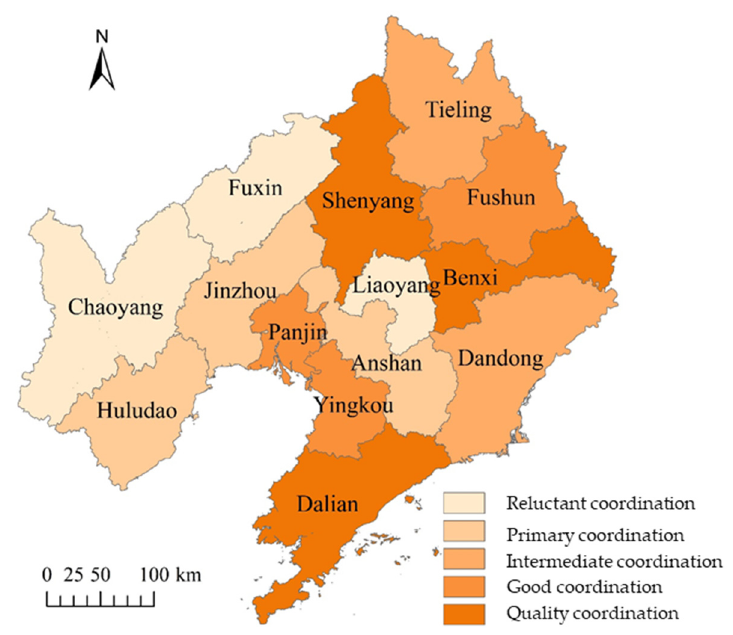
Figure 7. Distribution of coordination stage types of LCCC in Liaoning Province.